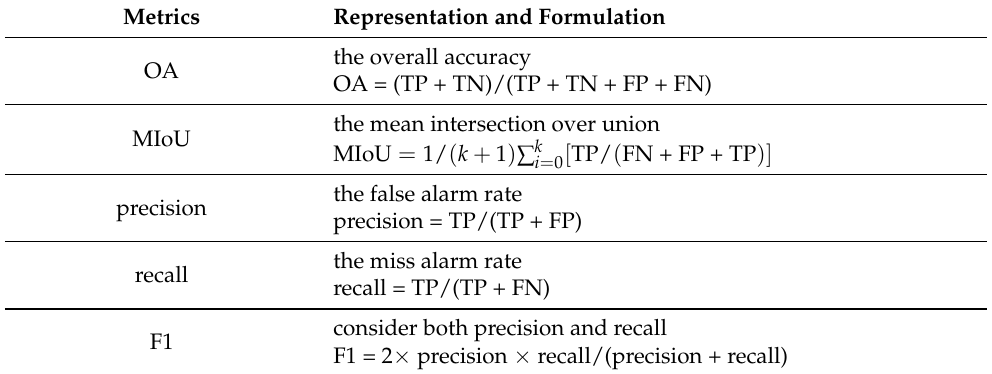
Table 3. The evaluating metrics.